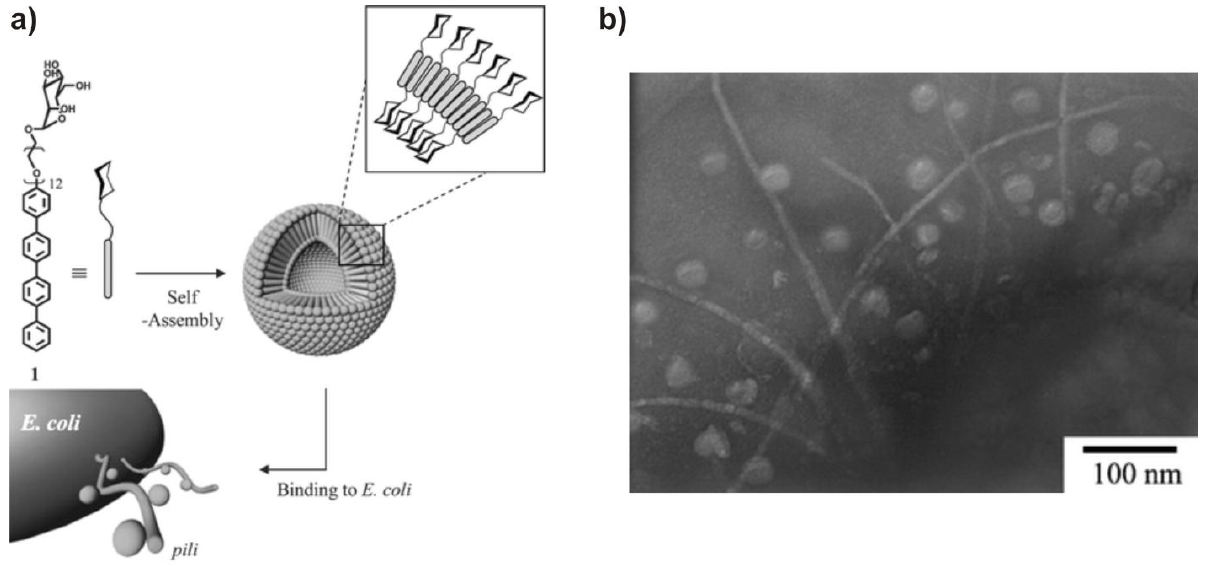
Figure 8. ( a ) Schematic representation of self-assembly of mannose-endfunctionalized polymeric rod coil amphiphiles into vesicles and their binding to the pili of E. coli . ( b ) TEM image of vesicles bound to the pili of an E. coli ORN 178 cell. Reproduced by permission of the Royal Society of Chemistry